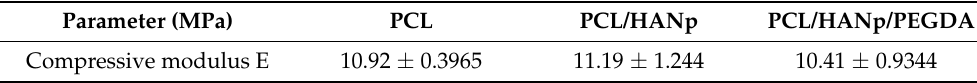
Figure 8. Compressive modulus (MPa) of the produced scaffolds. Table 3. Compressive mechanical properties of the formulations produced (mean ± sd values).